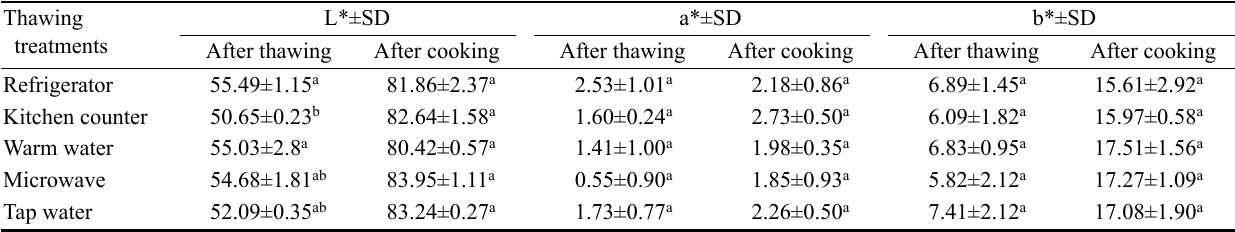
Table 5. Color values of chicken breast the samples after defrosting using home based thawing practices and cooking Thawing